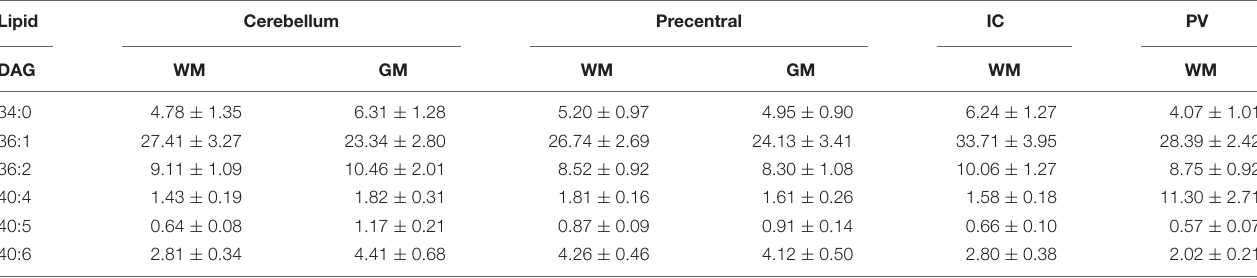
TABLE 1 | Levels of diacylglycerol (DAG) in regions of the formalin fixed human brain ( n = 21): cortical gray matter (GM) of the cerebellum, white matter (WM) of the superior cerebellar peduncle, cortical gray and subcortical white matter of the precentral gyrus, internal capsule (IC) and periventricular (PV) white matter. Lipid Cerebellum Precentral IC PV